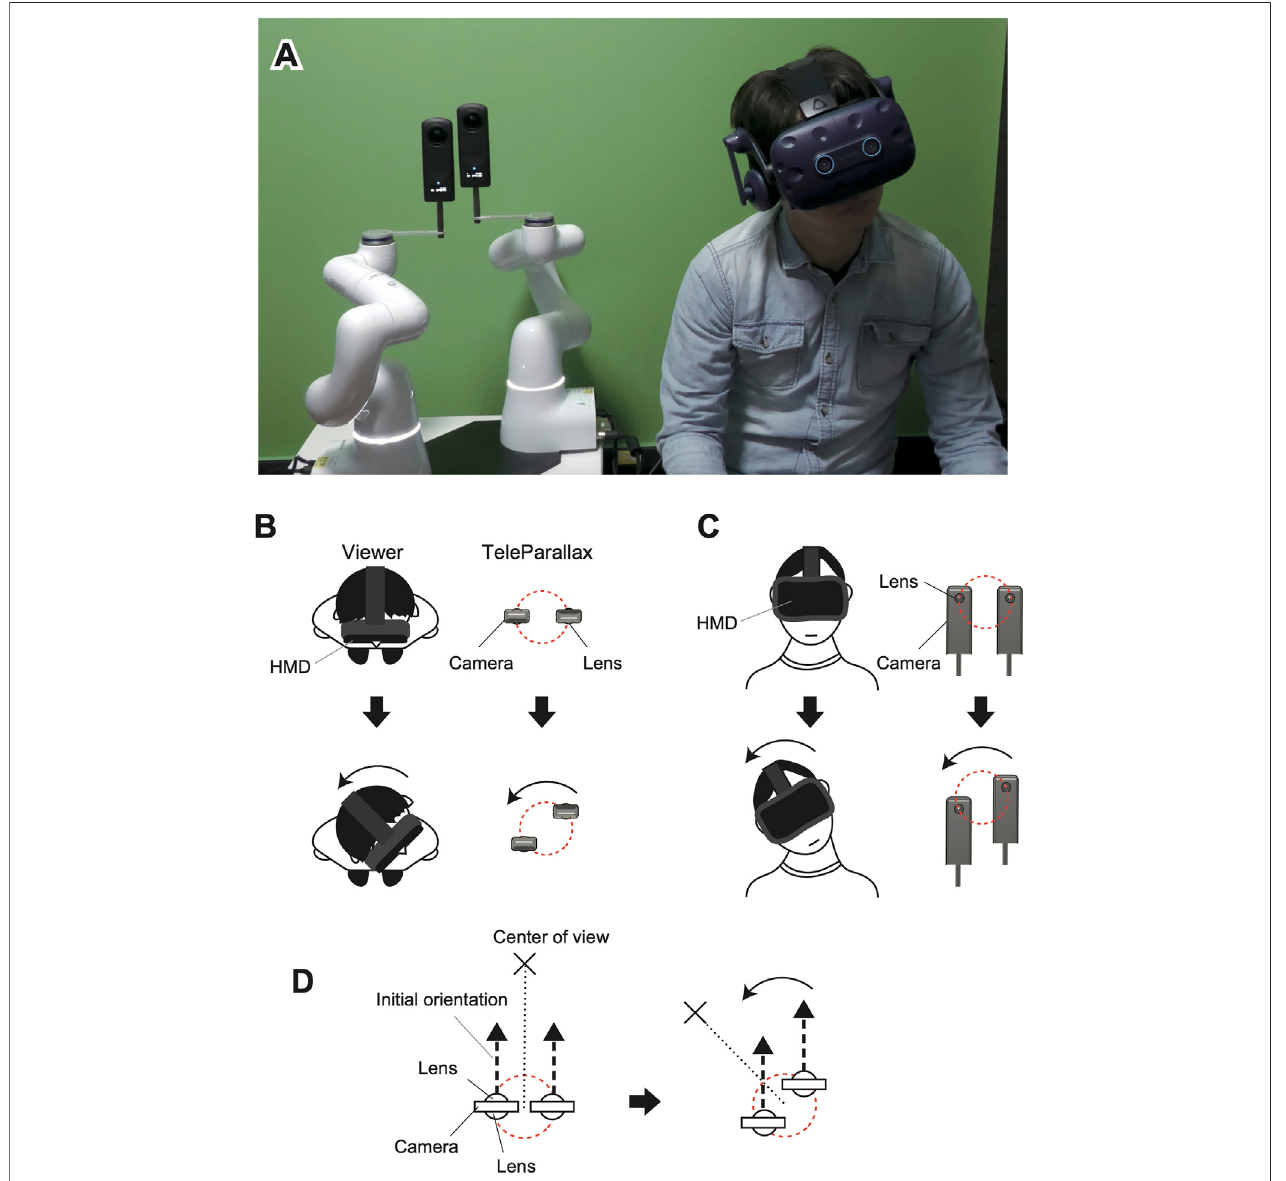
FIGURE 1 | TeleParallax system (A) . Lens movement according to head rotation in the yaw (B) and roll (C) directions. The initial orientation of the cameras is kept unchanged when the center of view is changed (D) .